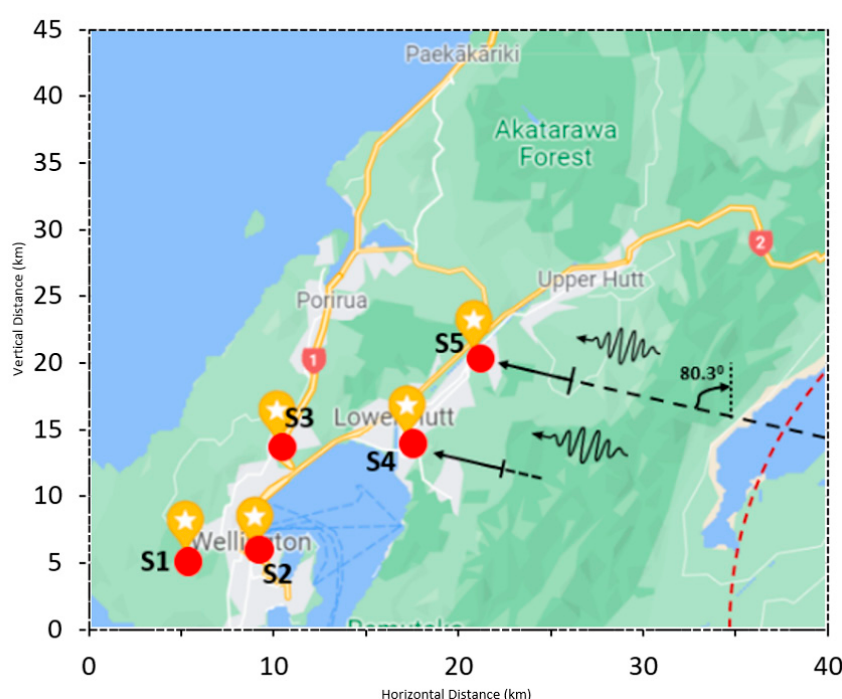
Figure A5. Scenario 5.